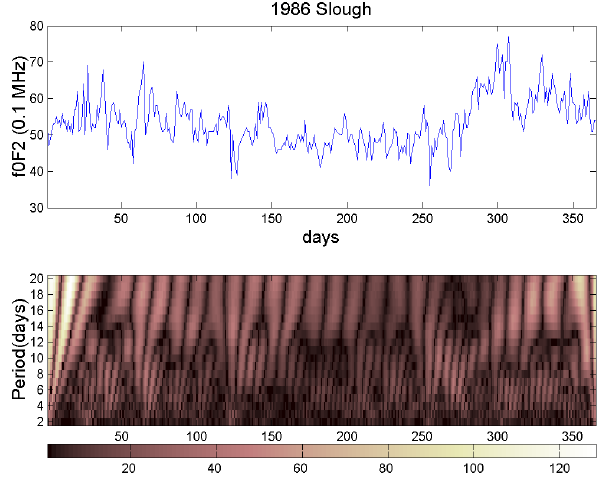
Table 2. Statistics of persistence of planetary wave type oscillations in fo F2 over Europe, 1979–1989, based on the Meyer wavelet transform. The average values for medians and the most frequent values are presented with step 0.5 Station Period (days) Number of events Median value Mean Value Most frequent value Juliusruh 5 45 4 10 39 Slough